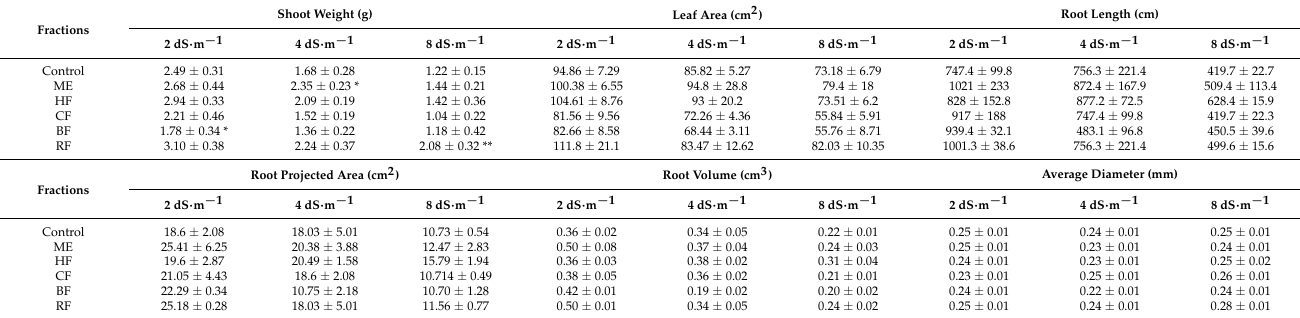
Table 2. Effect of Ulva lactuca methanol extract (ME), hexane fraction (HF), chloroform fraction (CF), n-butanol fraction (BF), and residual fraction (RF) application on growth traits of tomato plants growing in different salinity levels (2, 4, 8 dS · m − 1 ). The control corresponds to plants with seeds primed in distilled water. Values are given as mean ± Standard deviation (SD).